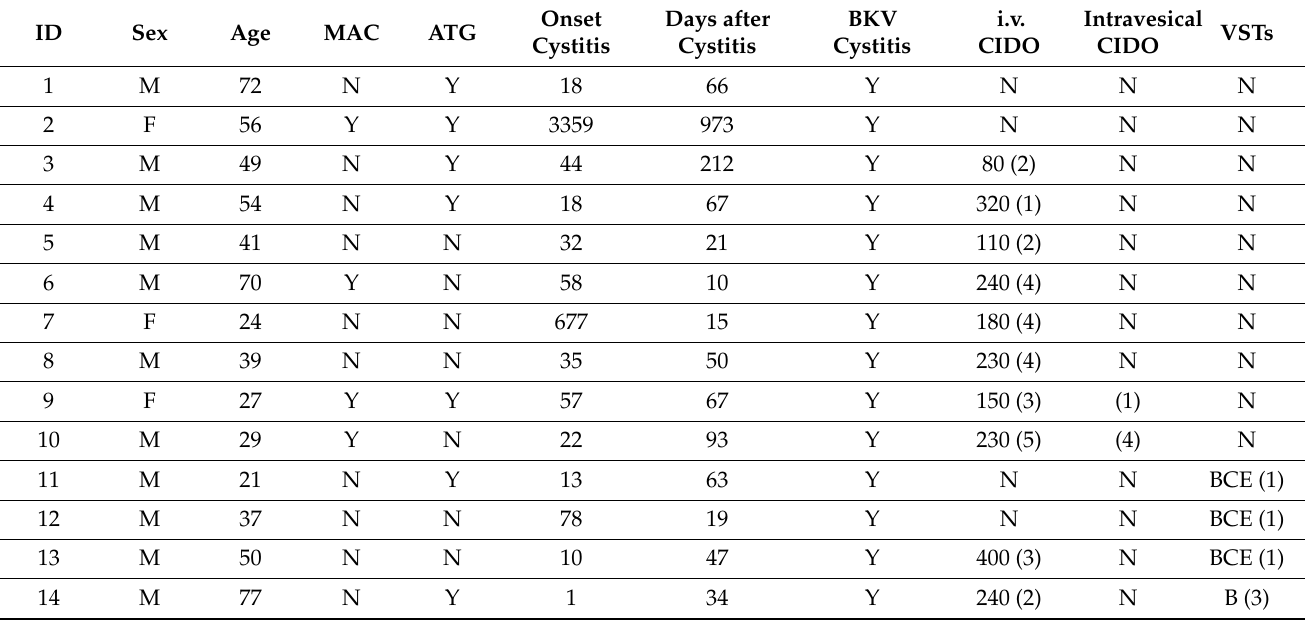
Table 1. Characteristics of 22 hematopoietic stem cell transplant recipients with